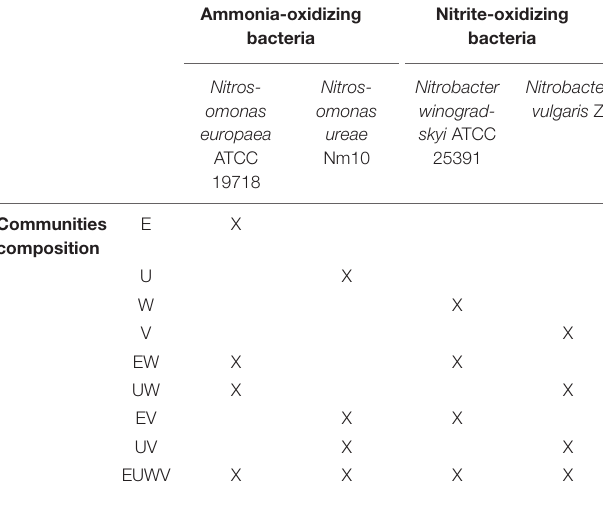
TABLE 1 | Overview of the individual strains and of the composition of the nitrifying synthetic